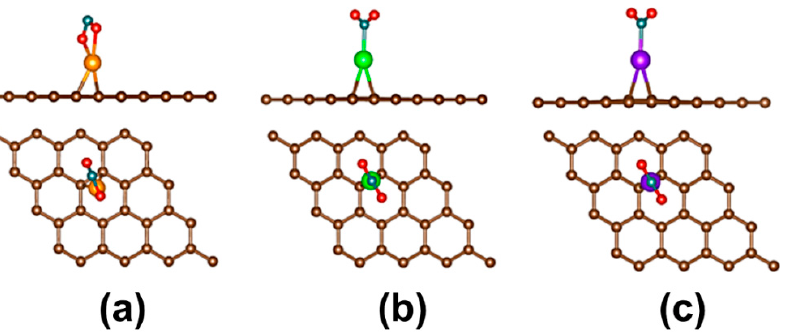
Figure 3. Top view (top) and side view (bottom) of optimized geometry for NO 2 adsorbed on ( a ) Ni/graphene decorated with Ni, ( b ) graphene decorated with Pd, and ( c ) graphene with Pt. Figure obtained from [51]. Table 2. Adsorption energies of toxic gases on transition metals decorated